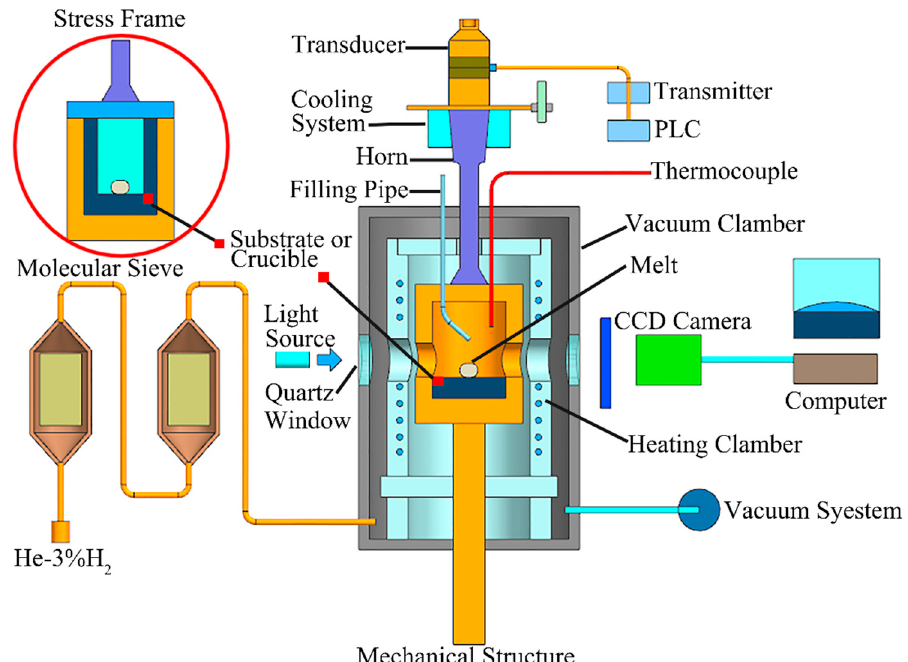
Figure 1. Structural diagram of the novel ultrasonic field wetting angle measuring instrument.